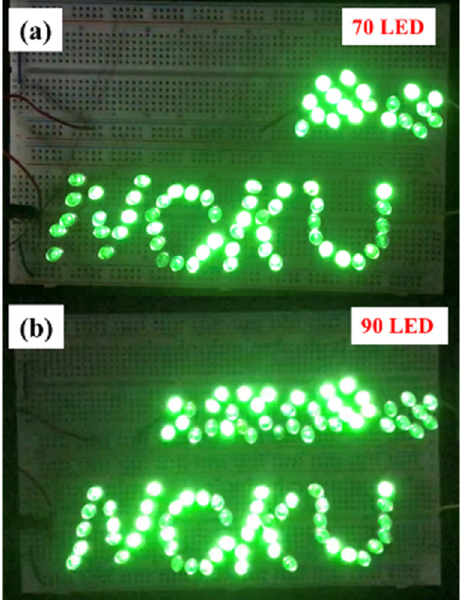
Figure 8. ( a ) Unstructured FTENG can drive 70 LEDs and ( b ) MN-FTENG can drive 90 LEDs.